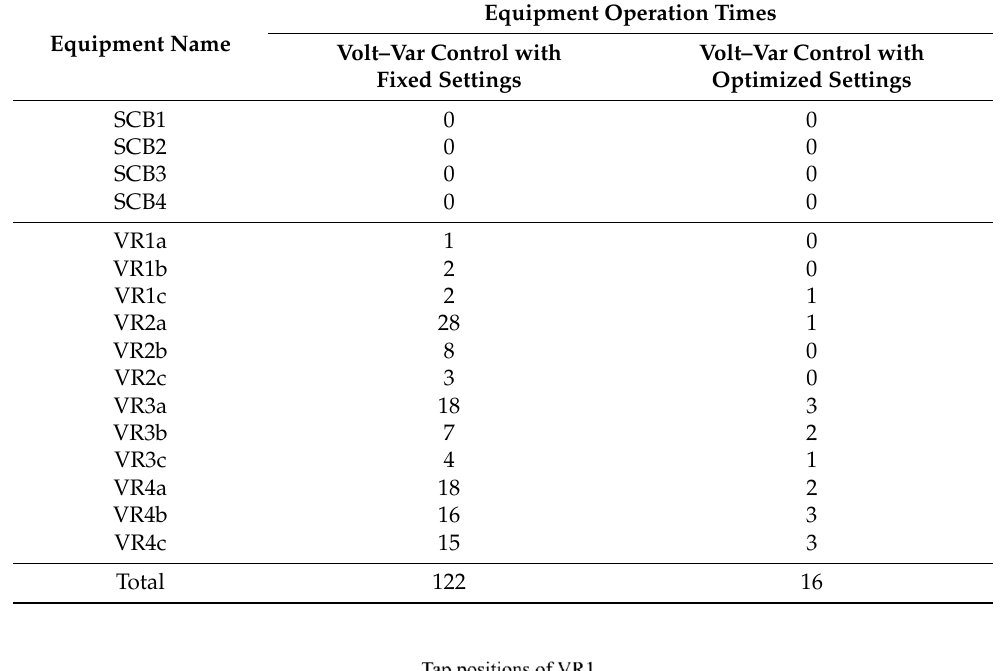
Table 3. The number of changes in VR tap positions and SCB status. Equipment